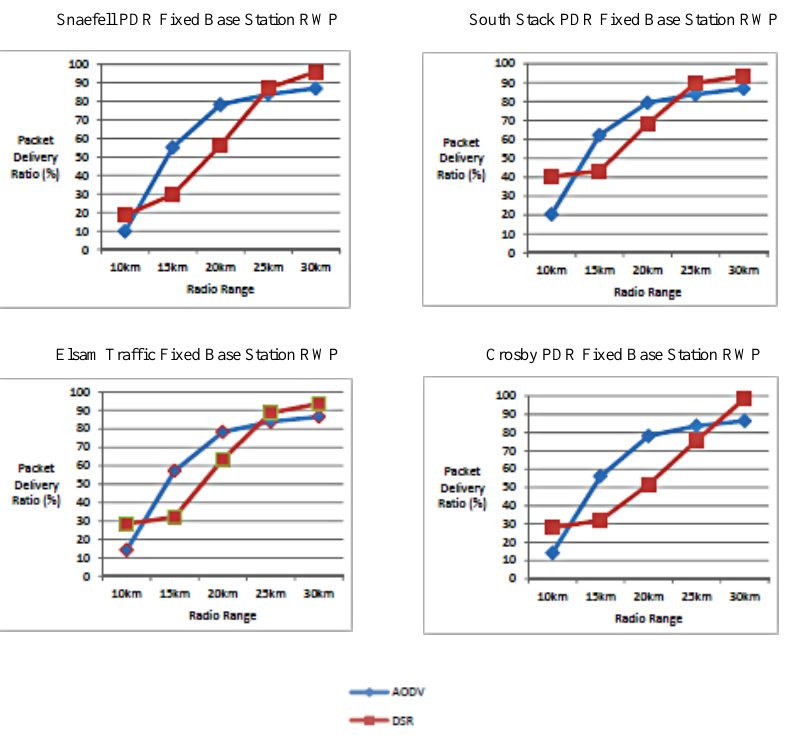
Figure 14. Moving Base Station Random Waypoint Model Packet Delivery Ratios.